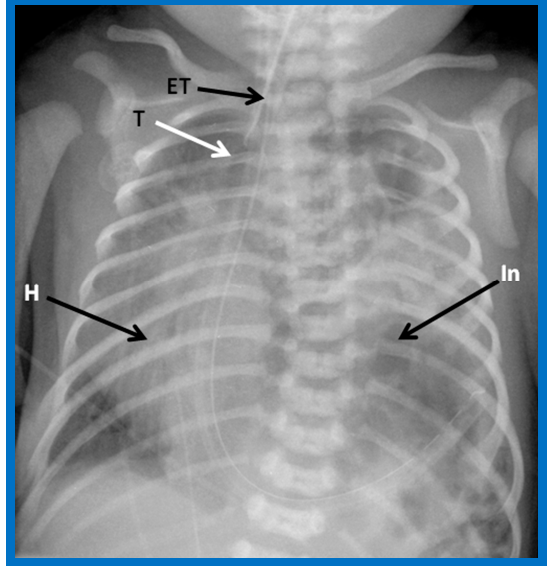
Figure 7. A chest roentgenogram of an infant demonstrating dextroposed heart (H) secondary to diaphragmatic hernia on the left side. The abdominal contents, including intestines (In) are relocated to the left side of the chest because of the diaphragmatic defect, pushing the heart into the right